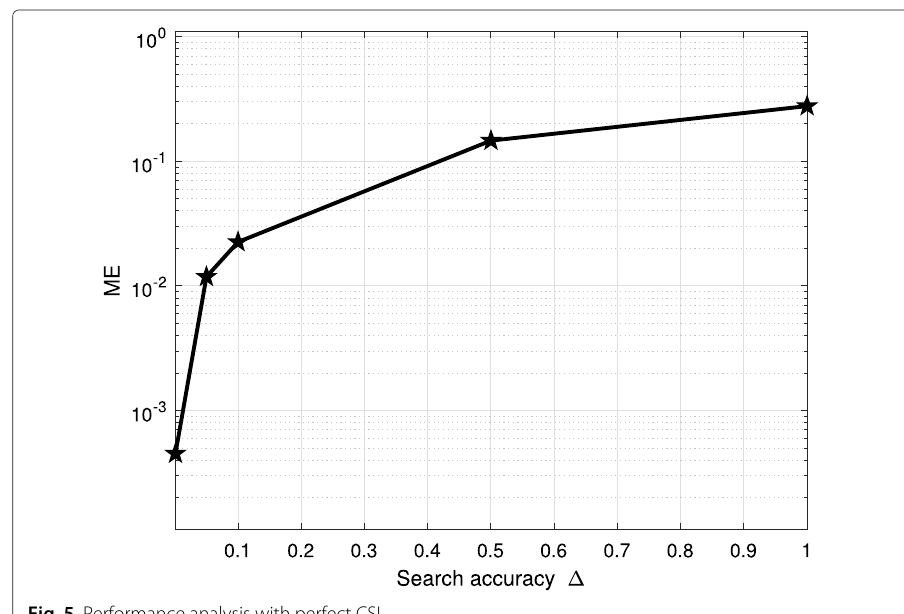
Fig. 5 Performance analysis with perfect